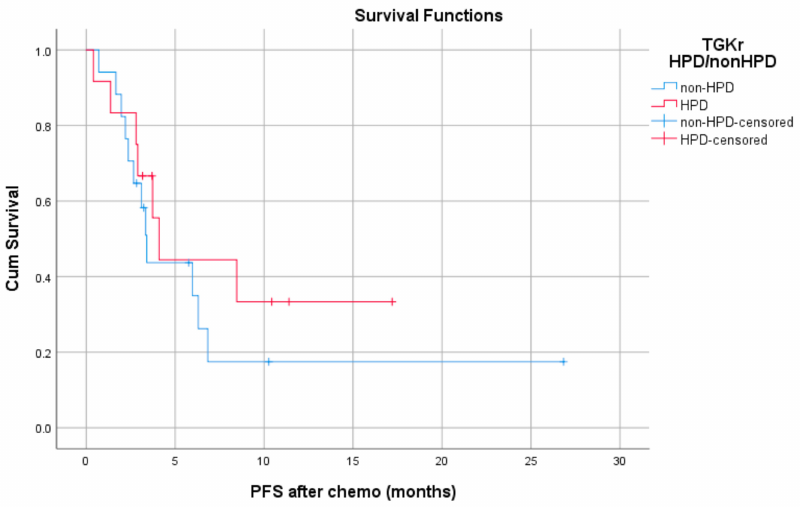
Figure 4. Association of type of progressive disease (HPD vs. non-HPD) with PFS of chemotherapy after immunotherapy failure (PFS